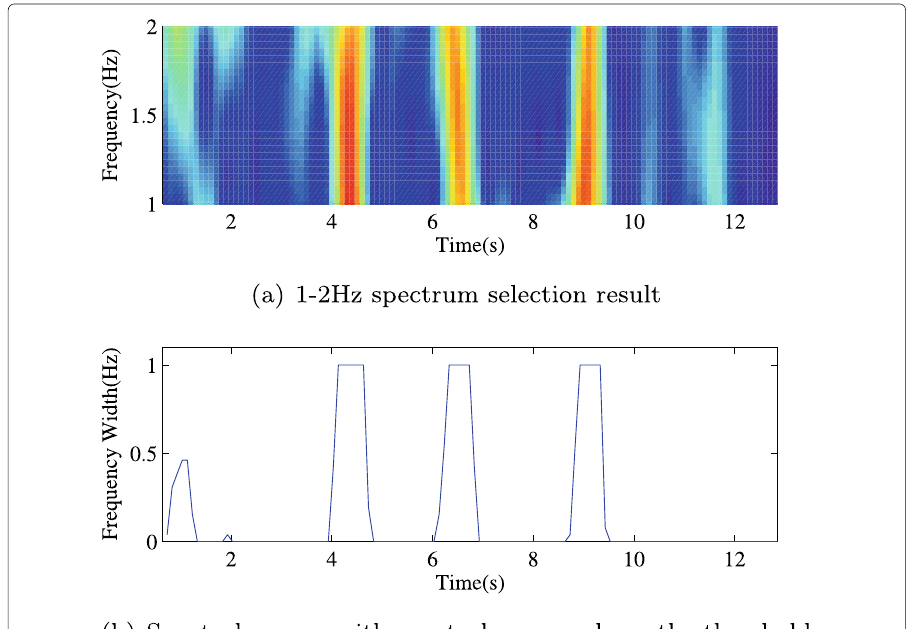
Fig. 7 Results for usage mode switching